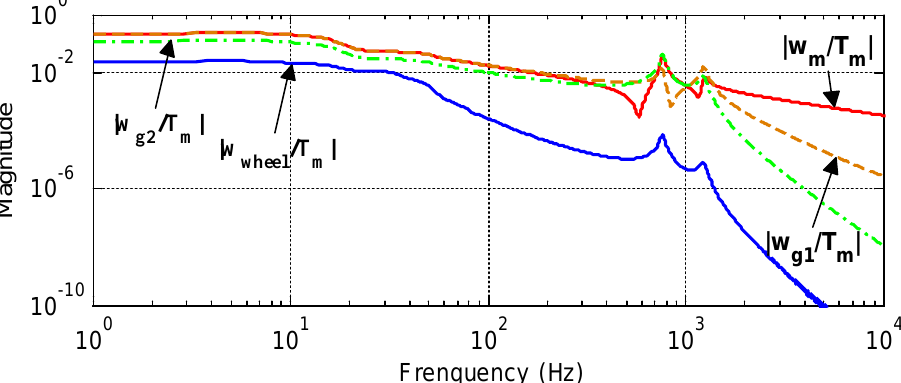
Figure 23. Frequency response of angular velocity of driveline components with input of motor torque.